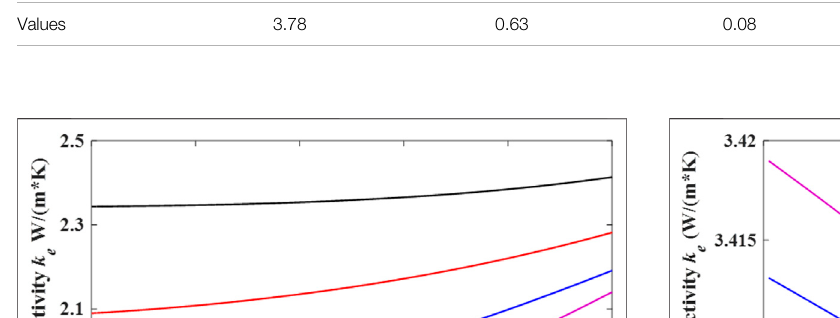
TABLE 2 | Default values of the parameters. Parameters